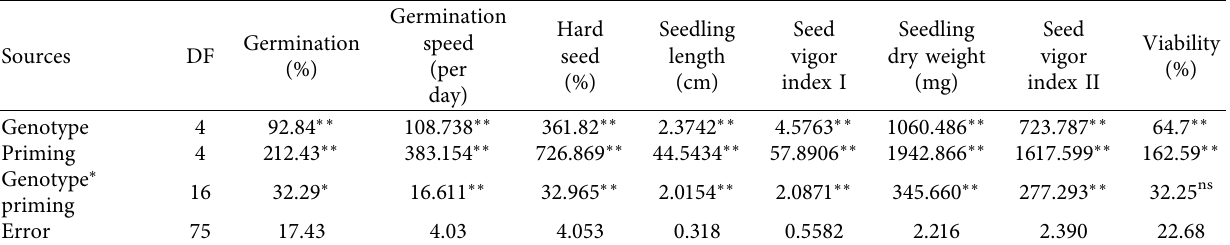
Table 3: Analysis of variance mean squares for the physiological seed quality test and number of hard seed for fve okra genotypes as infuenced by priming.